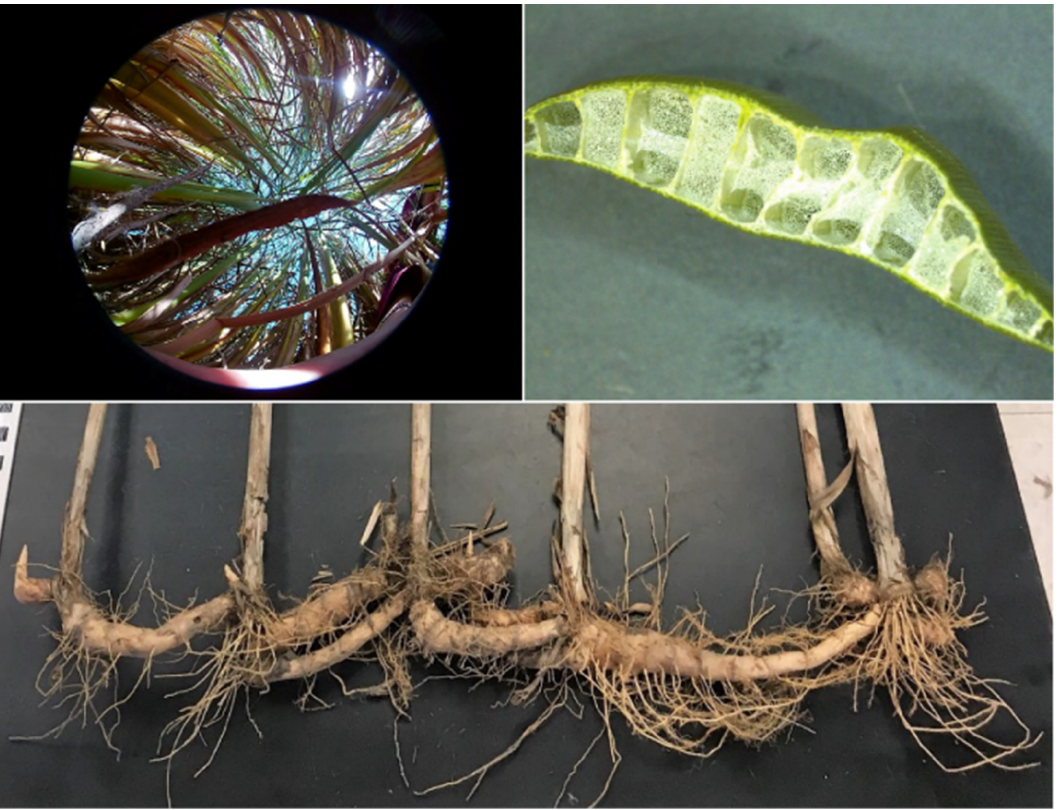
Figure 8. Cattail, Typha L. sp. Top left, shoots seen from below. Top right, a cross-section of a leaf with large air spaces, which are connected to air spaces throughout the plant. Bottom, rhizomes. Reproduced with permission from Bansal et al. [75].